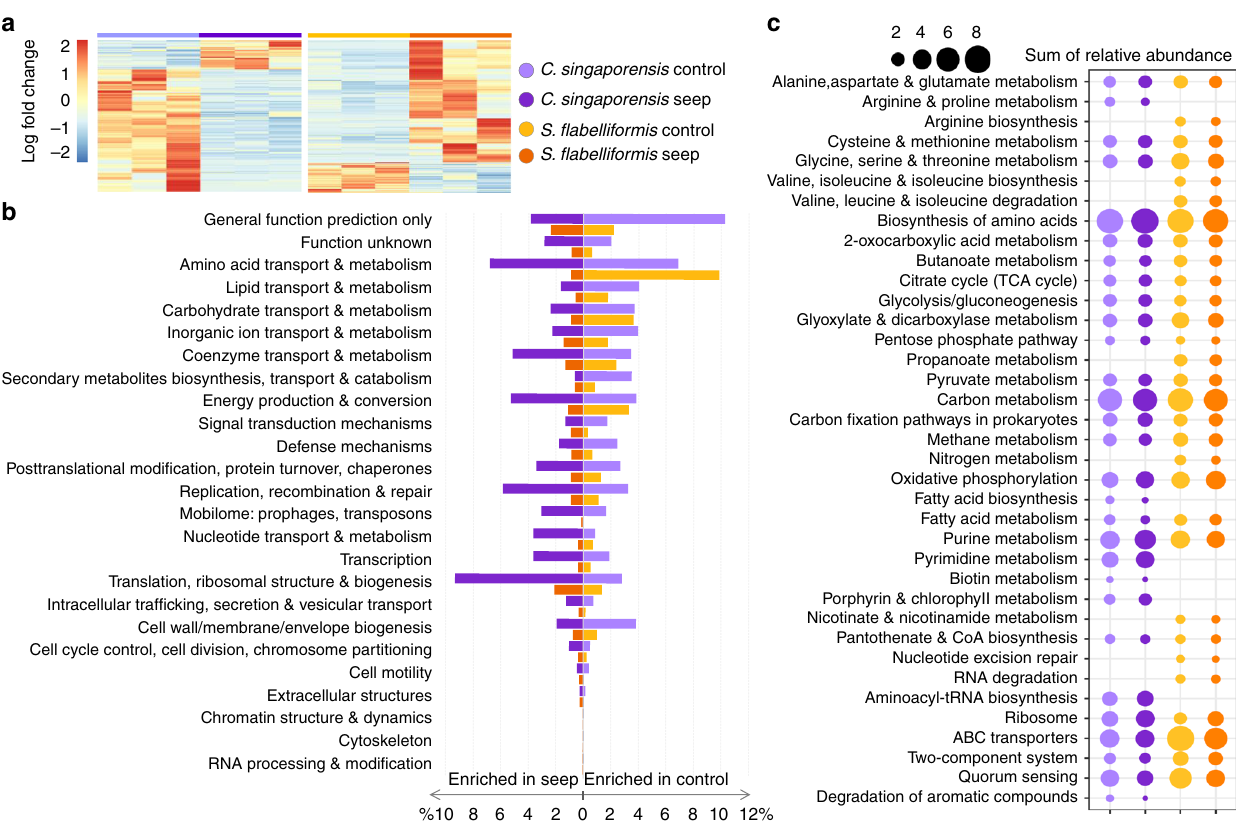
Fig. 1 Overview of functional genes in C. singaporensis and S. fl abelliformis at the CO 2 seep and adjacent control site. a Heatmap with all signi fi cantly enriched genes (KOs) according to ANOVA. b Distribution of all genes (COGs) that were signi fi cantly enriched (ANOVA, p < 0.05) at the control or seep site, grouped into COG categories. Mean relative abundances ( n = 3) were summed per COG category for each of the “ enrichment groups ” . c Relative abundance of the 30 most abundant pathways for each species (with total relative abundance >1% in control and/or seep site) based on ANOVA-derived statistically signi fi cant genes (KOs). Mean relative abundances ( n = 3) were summed per KEGG pathway for each of the “ enrichment groups ” . Mean relative abundances of all genes belonging to each of the pathways were summed regardless of p